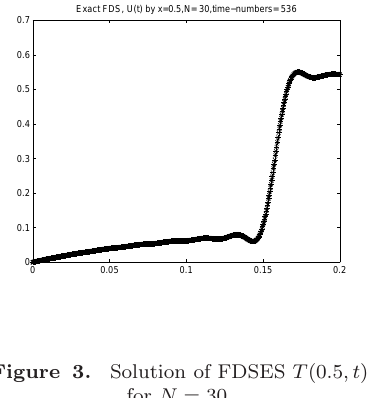
Figure 3. Solution of FDSES T (0 . 5 ,t ) for N = 30.